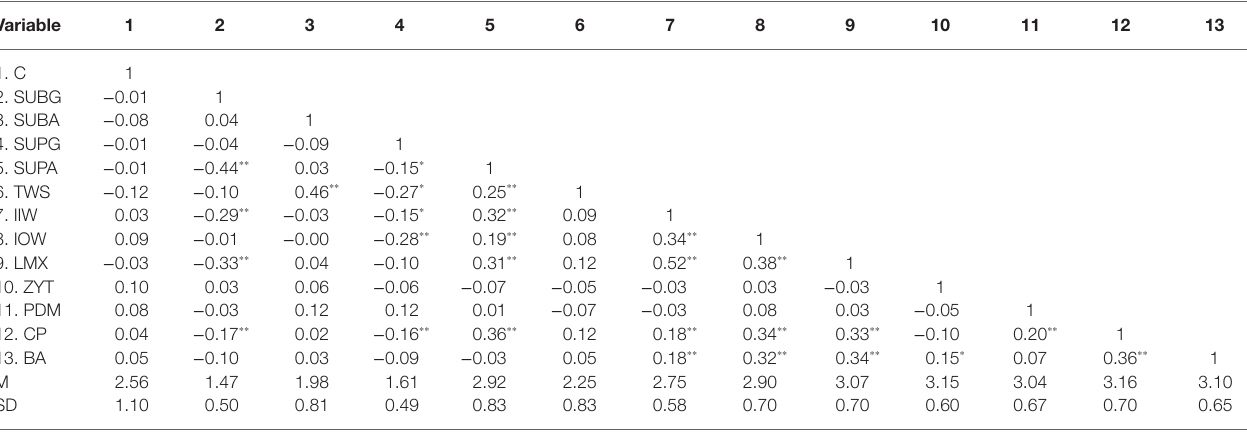
TABLE 2 | Means (M), SDs, and